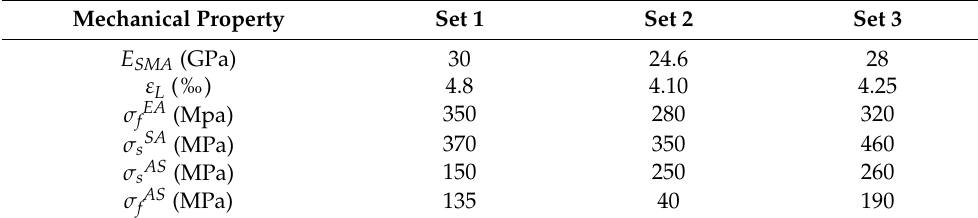
Table 1. Mechanical properties of SMA